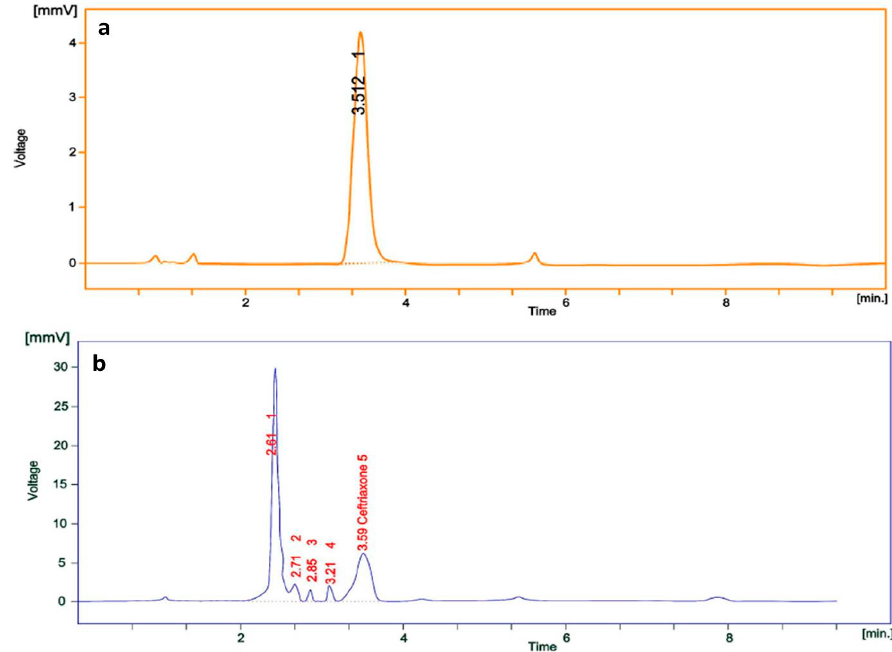
Figure 7. RP-HPLC chromatogram of ( a ) pure ceftriaxone and ( b ) CGNPs.